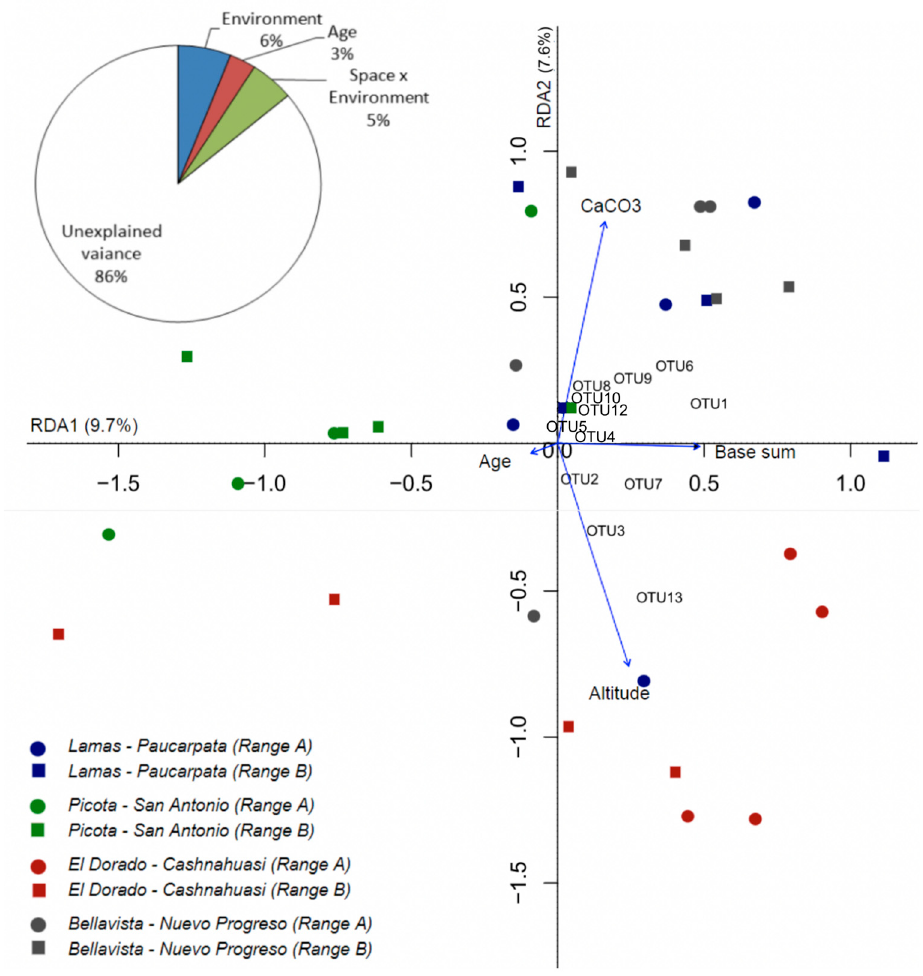
Figure 3. Ordination of the arbuscular mycorrhizal fungi community composition via redundancy analysis (RDA) (TRFLP database approach) in four localities in the San Martín region. The position of samples in the figure indicates their similarity (closer samples, more similar community composition) and correlation with shown variables (samples in the direction of arrows contains AM fungal taxa whose presence correlates with those variables). The pie chart shows a variance partitioning of the community composition by environmental factors (CaCO 3 , base sum and altitude), plot spatial position, and crop age. In the figure, age, altitude, CaCO 3, and base sum soil content were used as